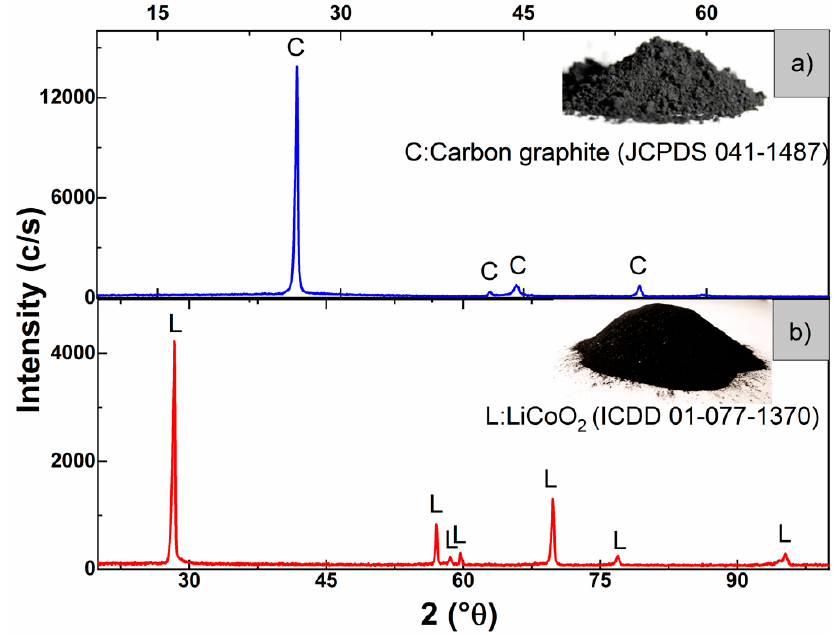
Figure 3. Results of the characterization of the active material of the ( a ) anode and ( b ) cathode, by XRD. Table 1. Atomic percentage of the electrode active materials composition.